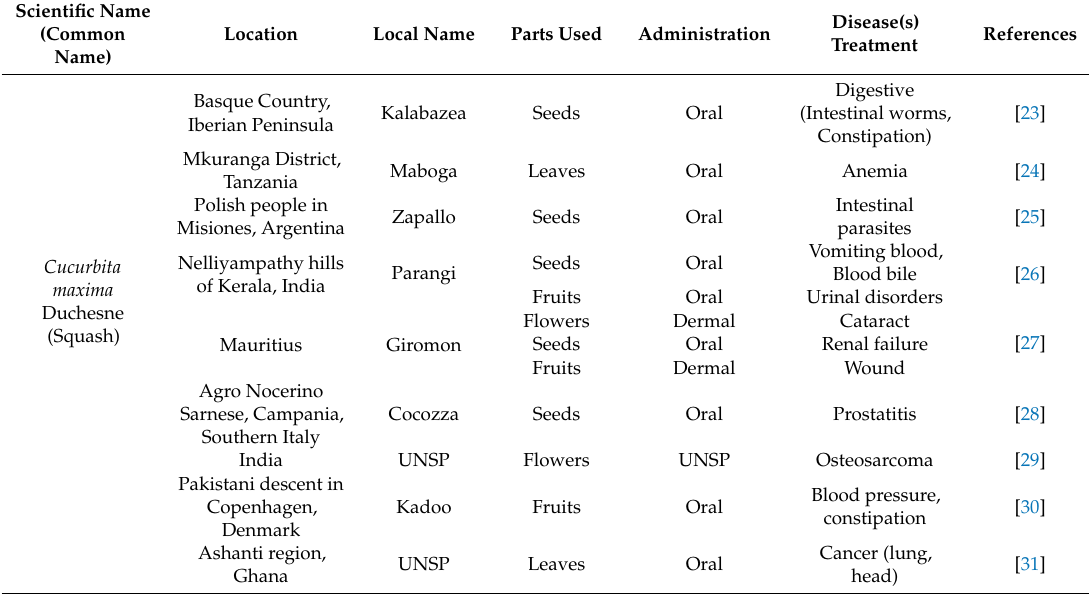
Table 1. Cucurbita plants traditionally applied in the cures of different diseases in diverse regions of the world.